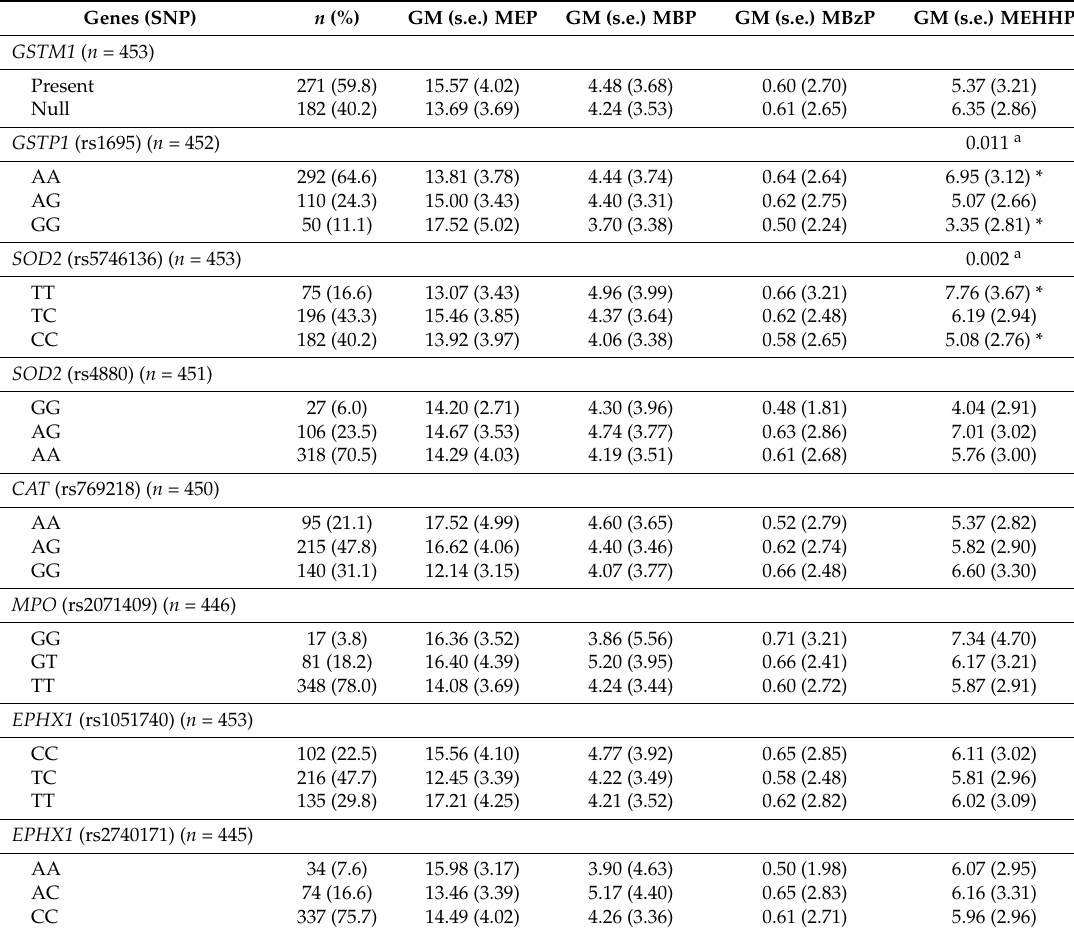
Table 4. The association of geometric means (s.e.) of urine phthalate metabolite levels (ng/mL) and different